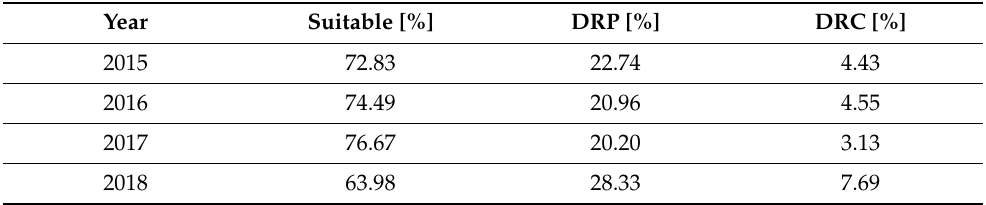
Table 1. Quality indicators of voltage level in Sample Campaigns carried out by ENEL Distribution S.A./Brazil from 2015 to